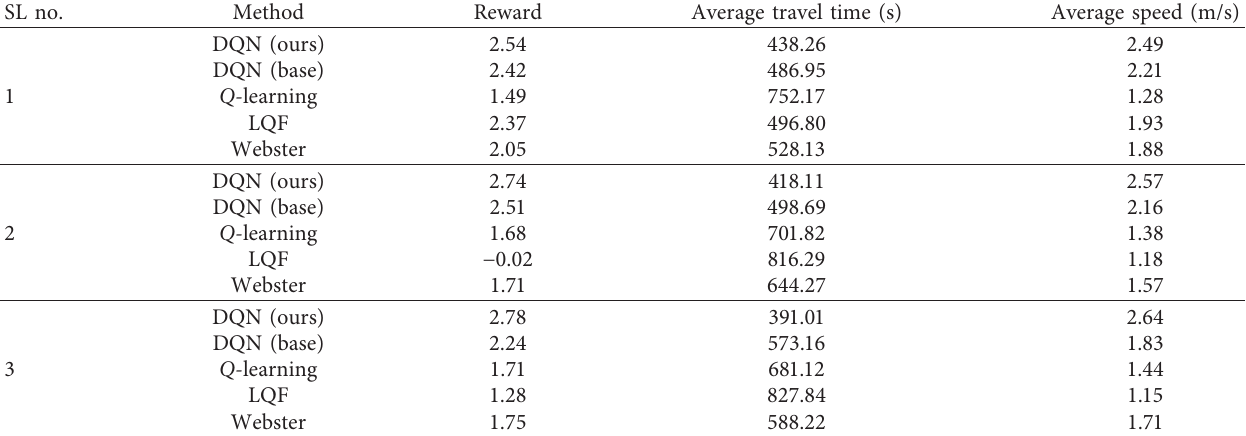
Table 5: Performance in multi-intersection case. Travel time: the lower the better; other measures: the higher the better. SL no.